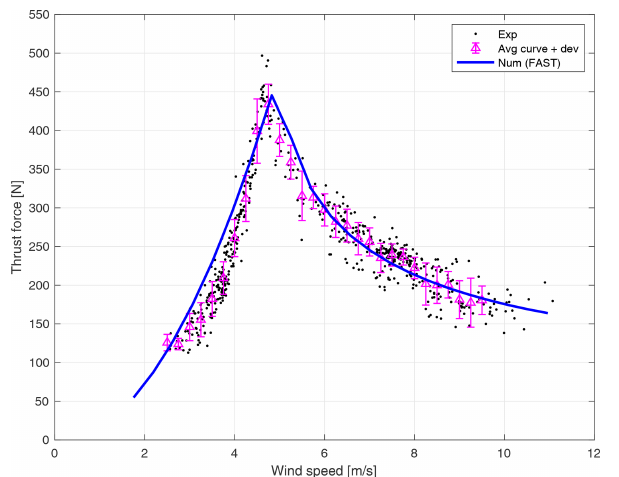
Figure 11. Comparison between the target and experimental thrust curve evaluated from tower deformation.